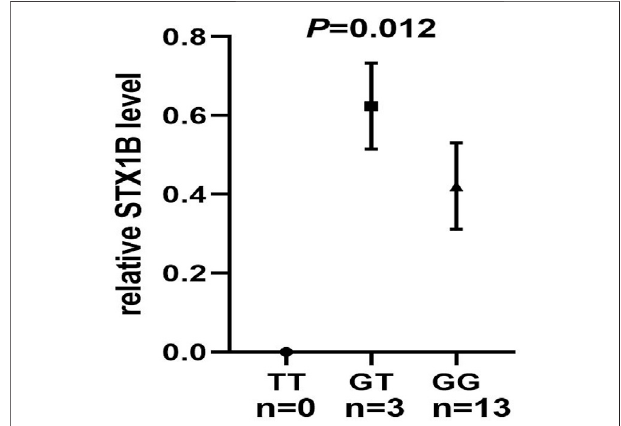
FIGURE 2 | The rs140820592 is an eQTL in temporal lobe tissue of drug-resistant epilepsy patients. The carriers of the T allele exhibited upregulated STX1B gene